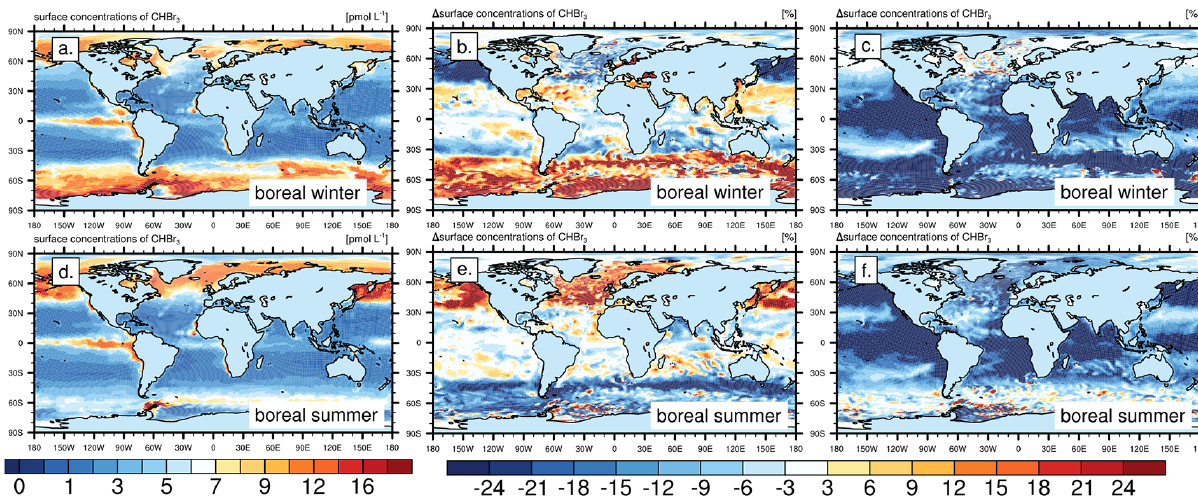
Figure 1. Mean surface bromoform concentrations (pmolL − 1 ) in experiment Ref in boreal winter (a) and boreal summer (d) and the percentage difference (e.g. 100 · Seas − at − Ref ) of Seas-at (b, e) and Half (c, f) in the same season. Ref